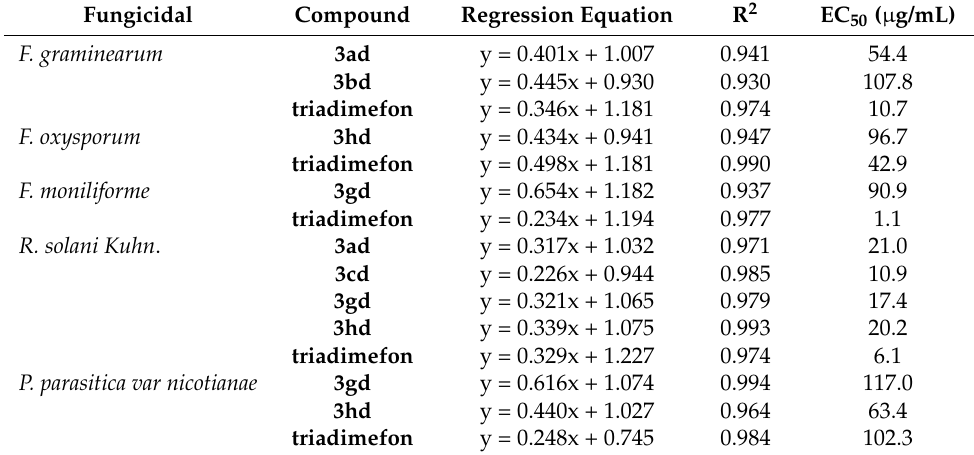
Table 4. In Vitro Potency (EC 50 ) of Compounds with Higher Preliminary Activities a .